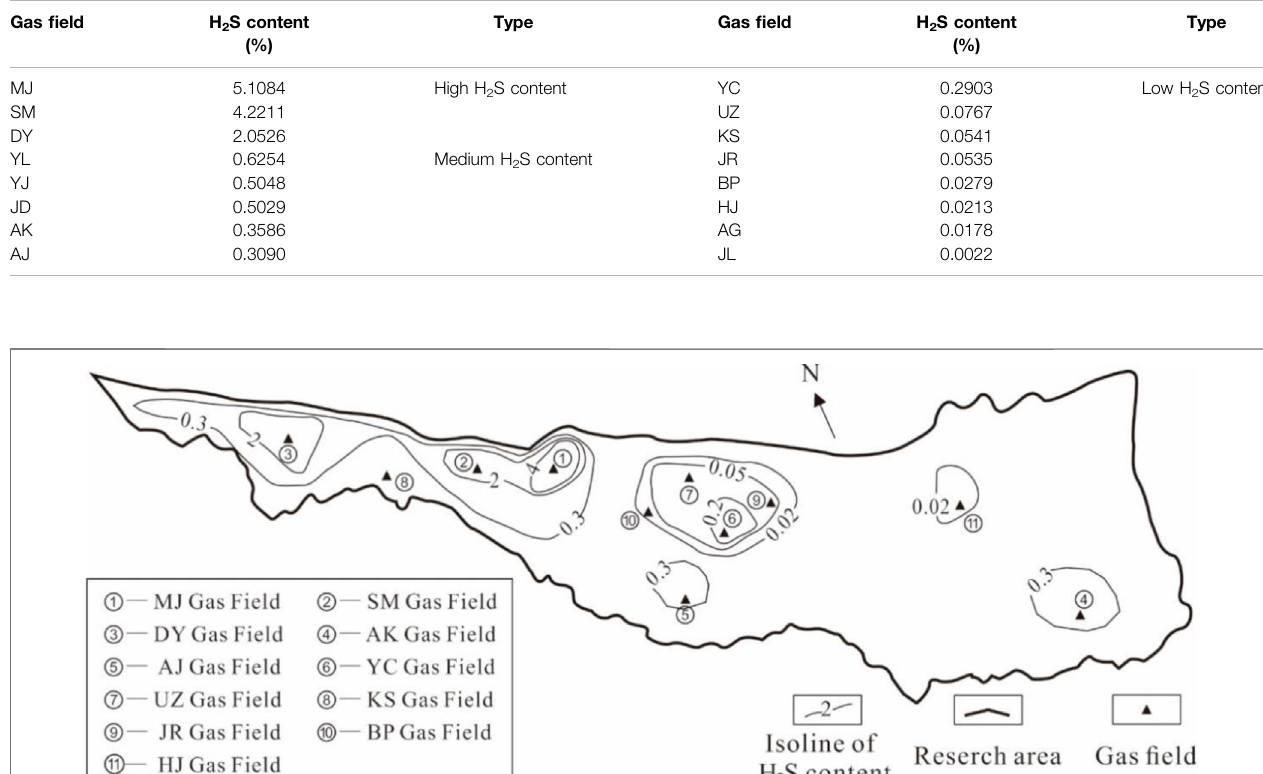
Frontiers in Earth Science |